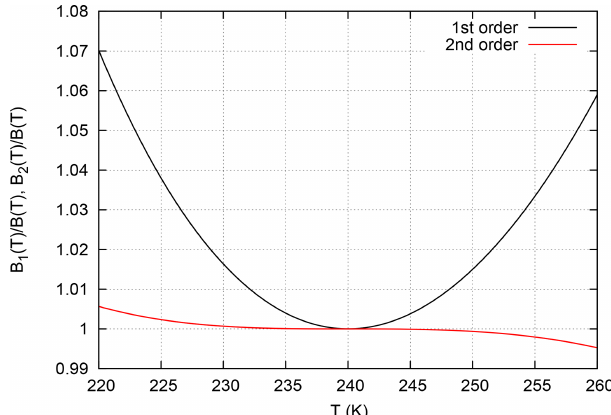
Figure 1. Ratio of the first-order (black) and second-order (red) ap- proximations to the correct Clausius–Clapeyron saturation pressure of water vapour.